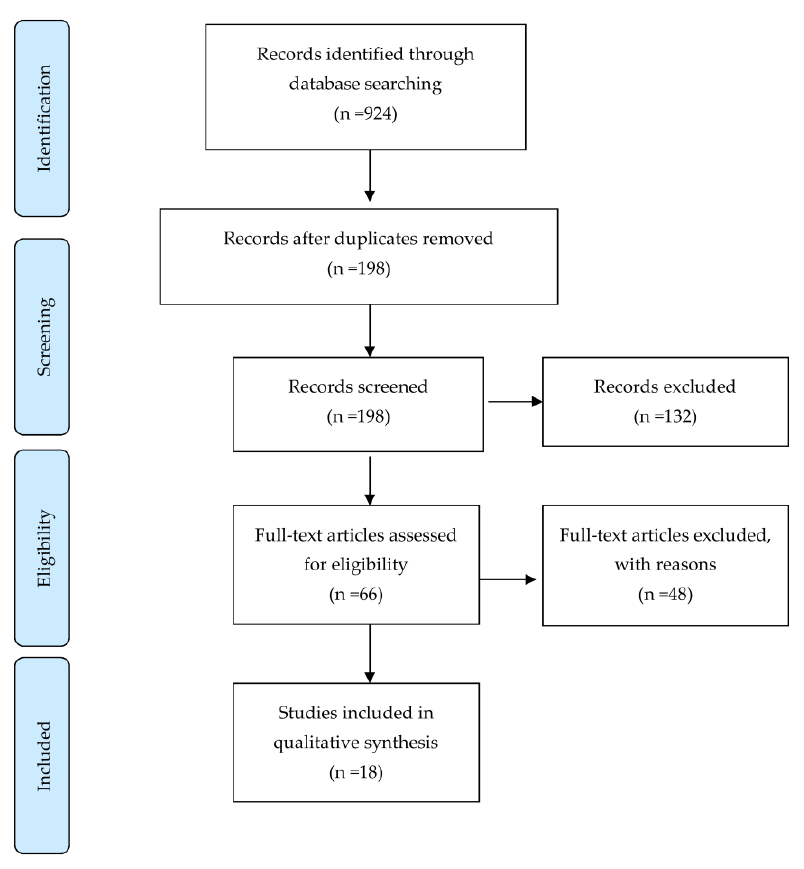
Figure 1. Study flow diagram. Changes in neuroplasticity associated with the amelioration of PSA are associated with the principle of intercerebral hemisphere inhibition and the relationship between the activation of the language areas and the activation of the language homologous areas. However, the role of the left and right cerebral hemispheres in the recovery process is still under debate, as described later. Early studies of rTMS for PSA showed that low- frequency rTMS (LF-rTMS) targeting Broca’s area was effective in brain reconstruction and contributed to the improvement of non-fluent aphasia [22,32]. The target of stimulation in many studies is the IFG in the right cerebral hemisphere [34] since the language homologous areas of the right cerebral hemisphere temporarily support language function when the major area of language in the left cerebral hemisphere is damaged. Over time, the language homologous areas are associated with maladaptation of activation of the language field in the left cerebral hemisphere